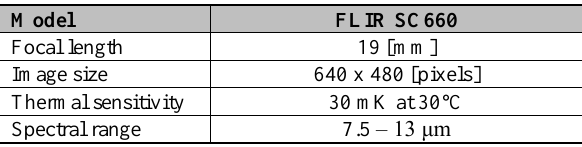
Table 2. Main specifications of FLIR SC660 thermal camera.